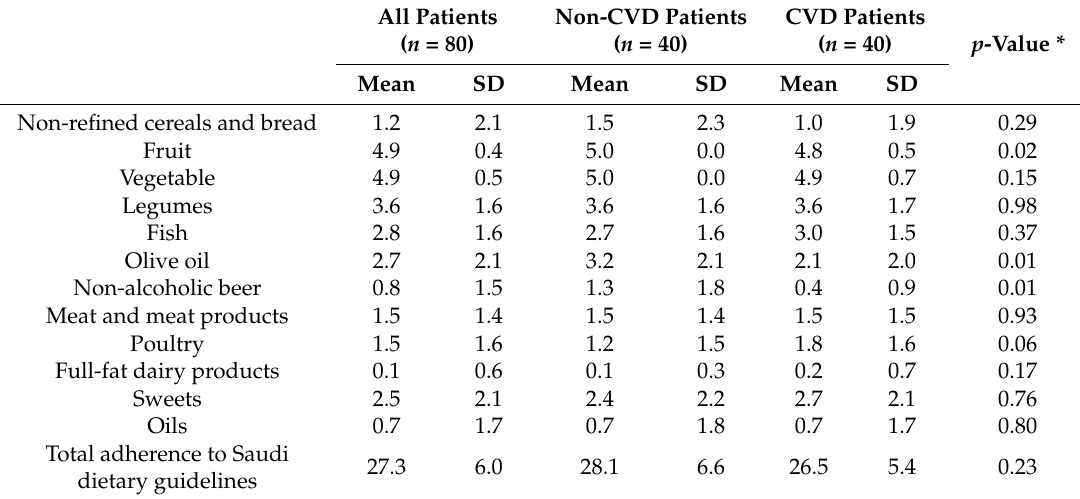
Table 5. The score of the adherence to the Saudi dietary guidelines.